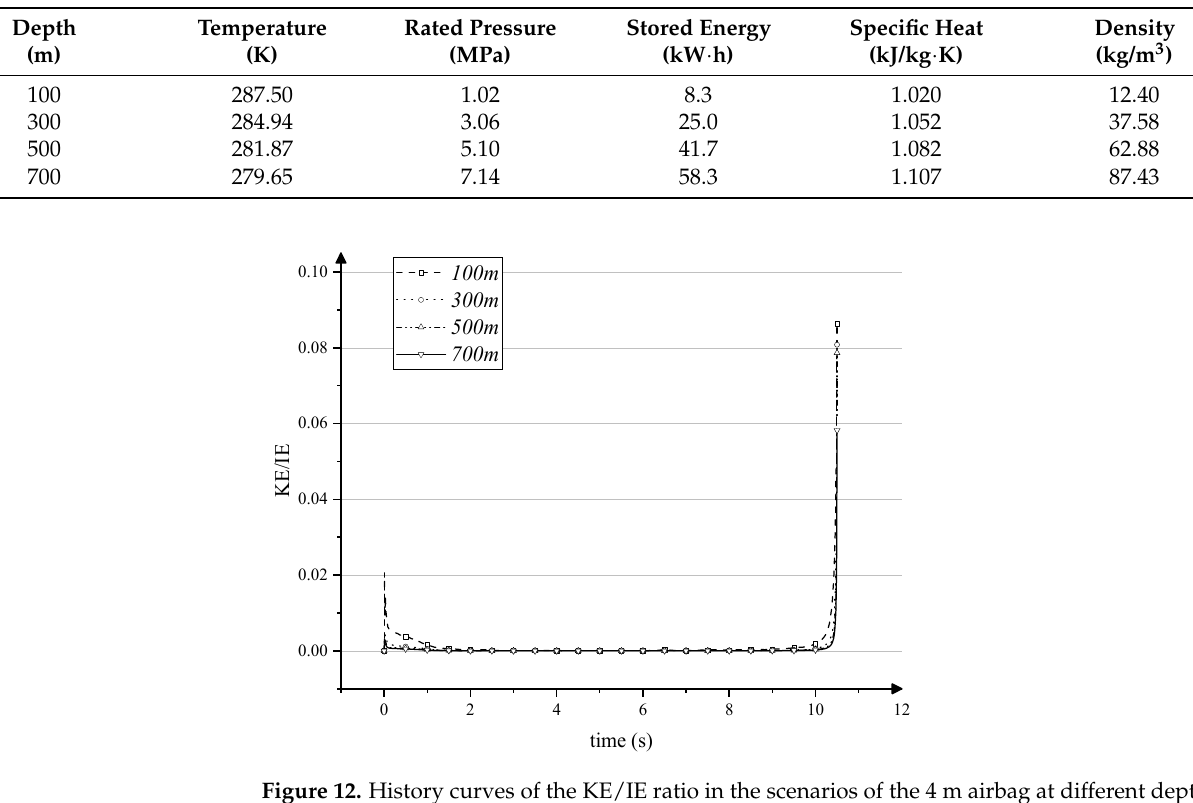
Table 5. Compressed air properties of a 4 m airbag at different depths.